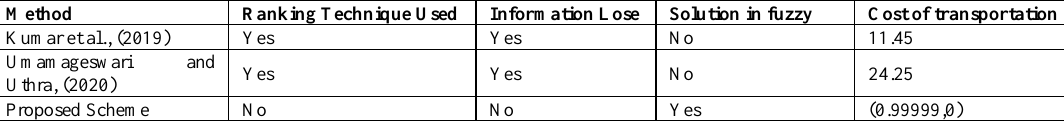
Table 9. Comparison based on optimal transportation cost for example